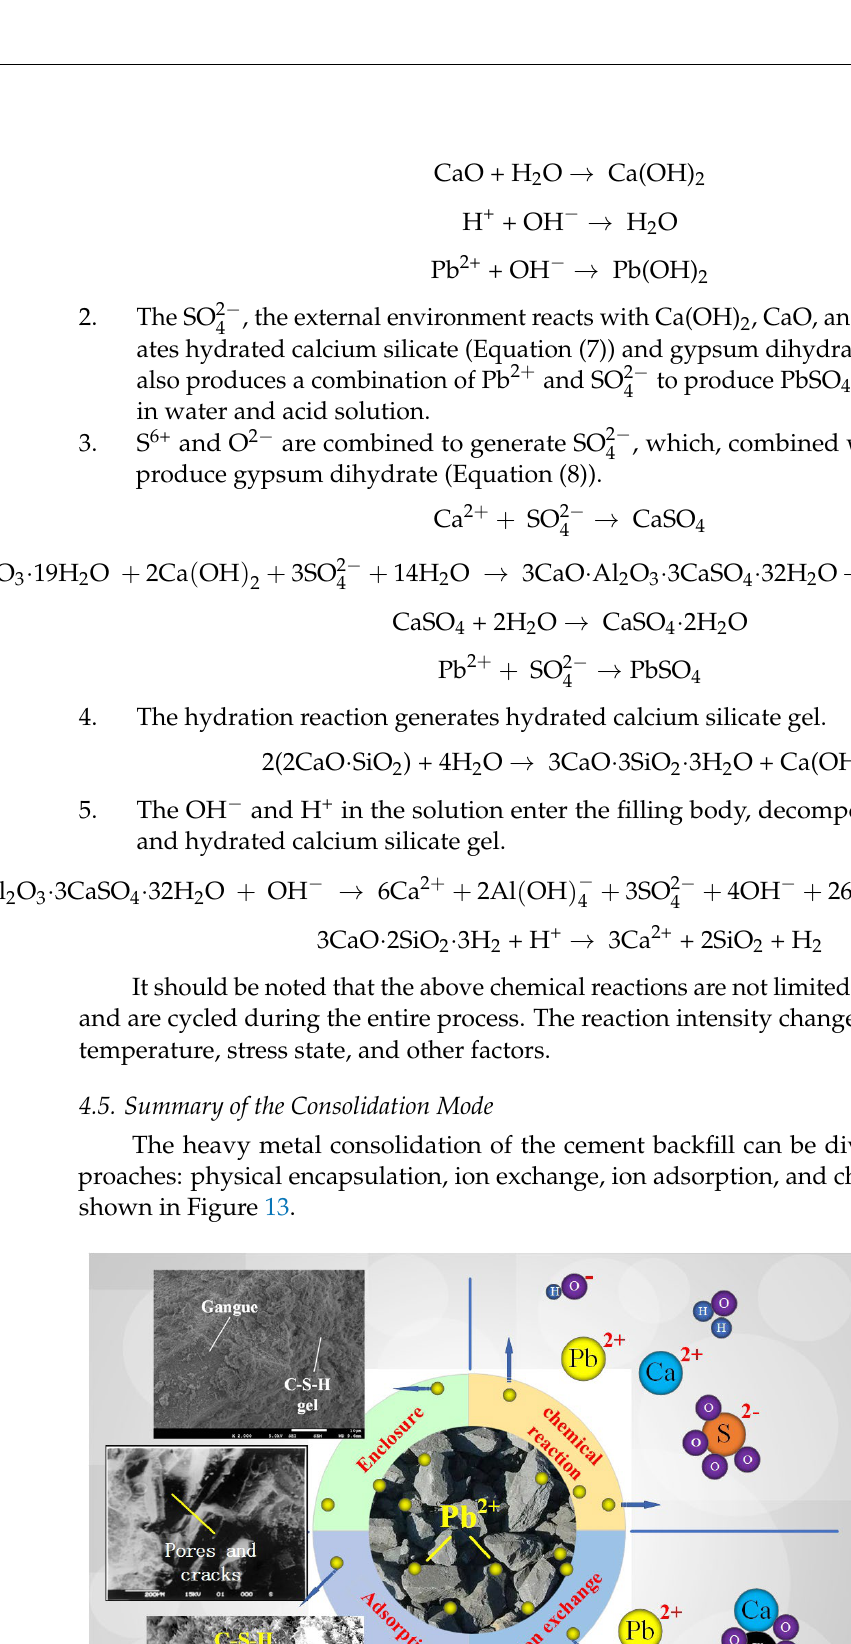
and coordination. For example, the chemical reaction and ion exchange are the main char- acteristics within the first 28 days of consolidation, because the strength of the filling body is low, and the external solution can enter the filling body in a relatively smooth way, reacting with the heavy metal elements and removing the heavy metal ions. After 28 days of the consolidation of the backfill body, its strength is close to peak values, and the hy- dration reaction forms a large amount of C-S-H gel, which forms an inclusion for the gangue particles, and the adsorption effect of the heavy metal elements is greatly